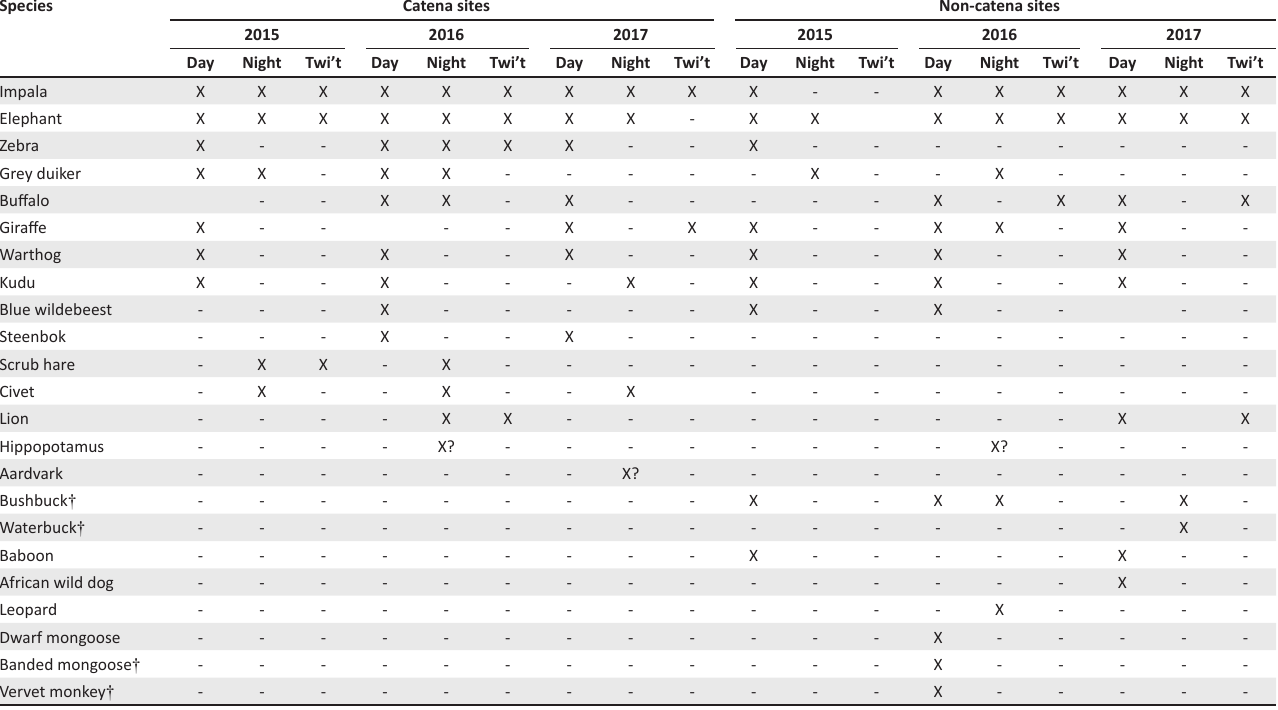
TABLE 3: These mammals were observed on the cameras to utilise the study area and surrounds in the day, night or civil twilight (Twi’t) during each survey period by feeding, resting, socialising, wallowing or drinking. It was uncertain if hippopotamus and aardvark utilised the area. Many animals just seemed to be passing through the granite catena, not utilising the area, and therefore their activity is not indicated in the table.